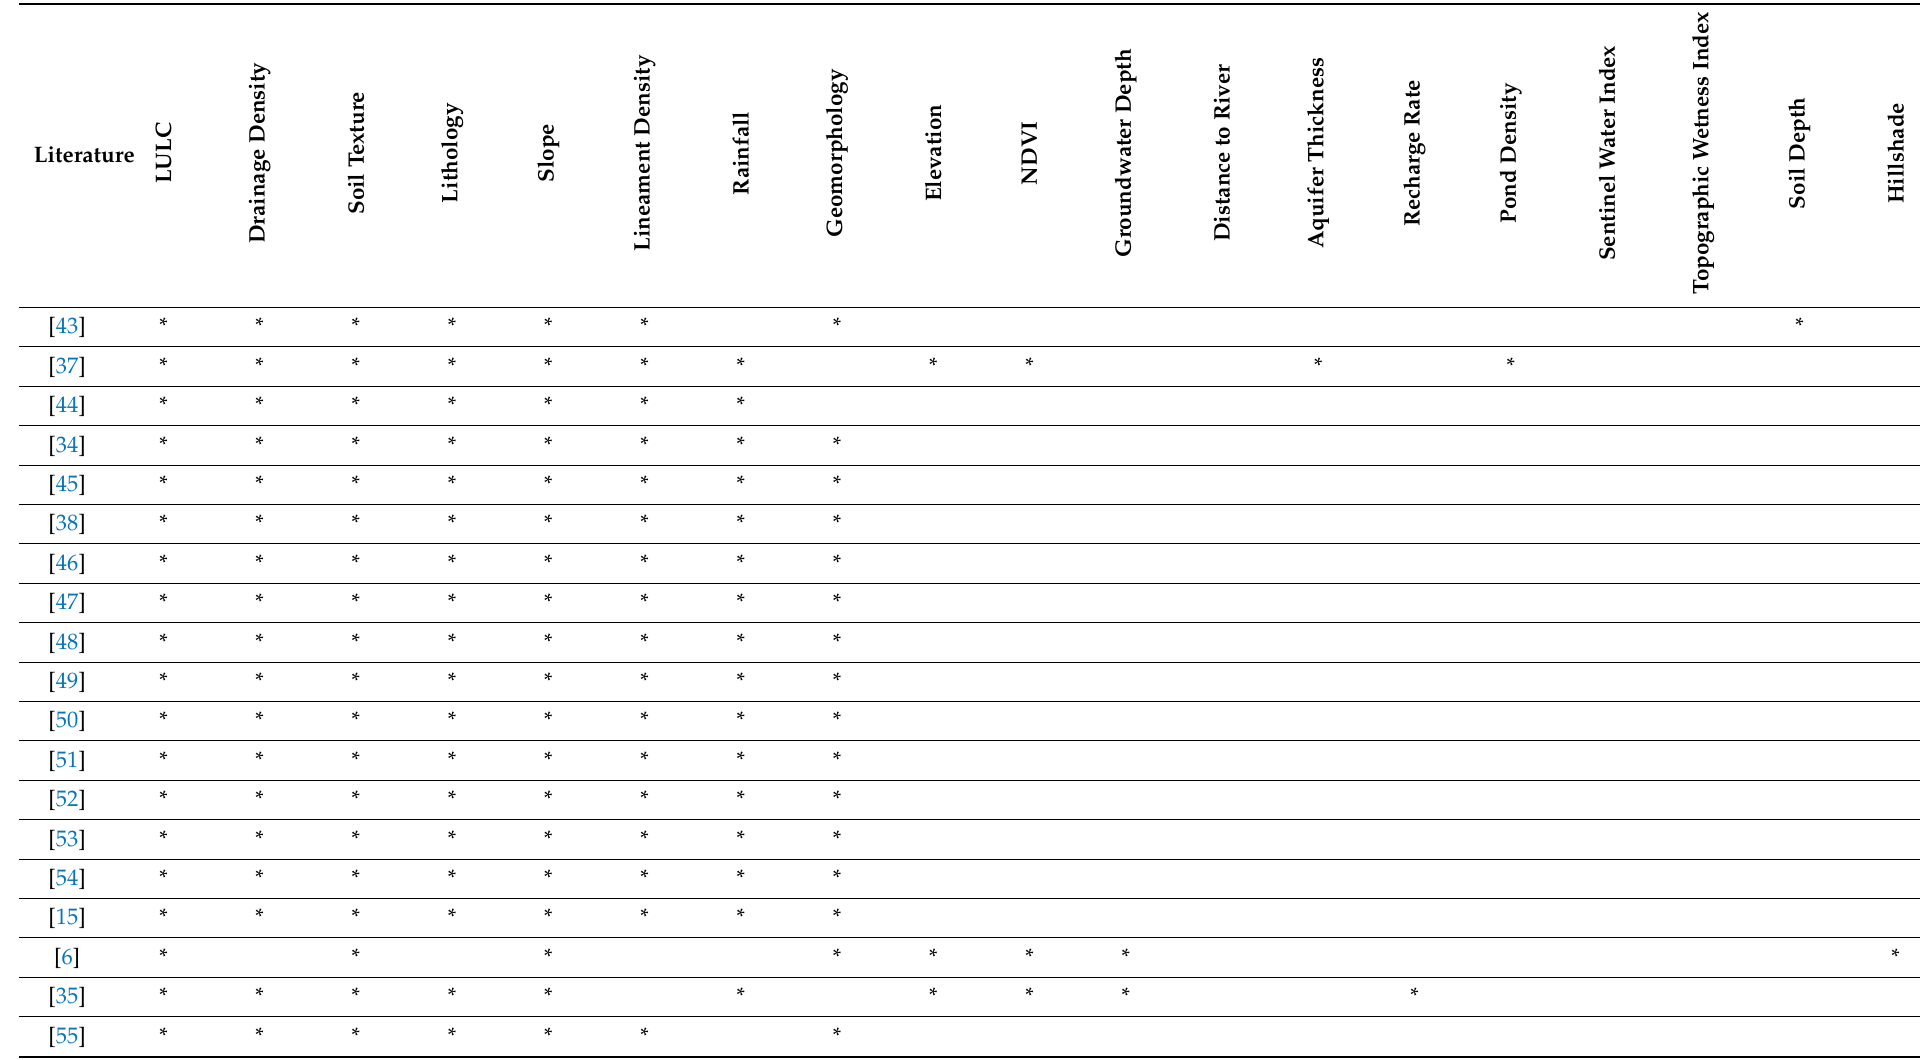
Table 1. Literature review of the factors used to map potential groundwater